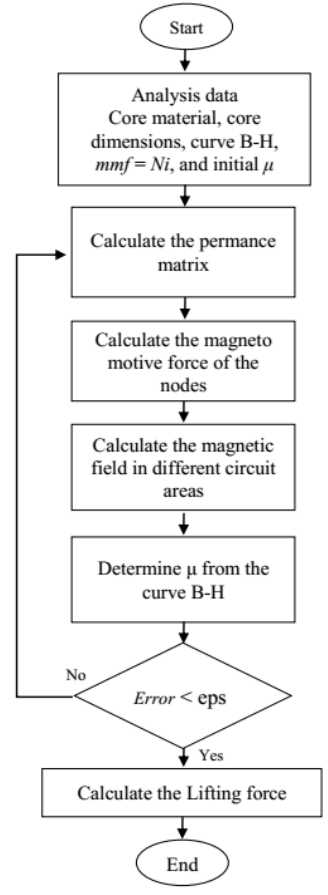
Figure 3 : Proposed algorithm for electromagnet